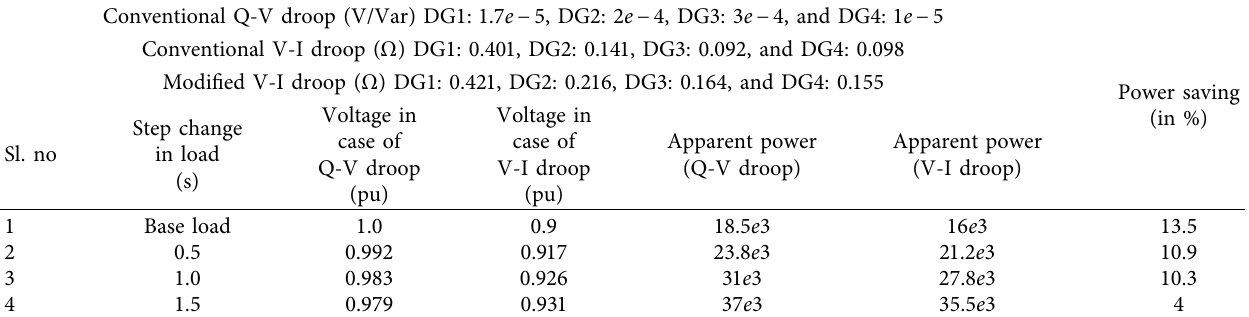
Figure 20: Reactive power consumption of 9 bus system at various power factor condition (a) at 0.8 power factor, (b) 0.85 power factor, (c) 0.9 power factor, and (d) unity pf. Table 4: Representation of power saving in IEEE 9 bus test